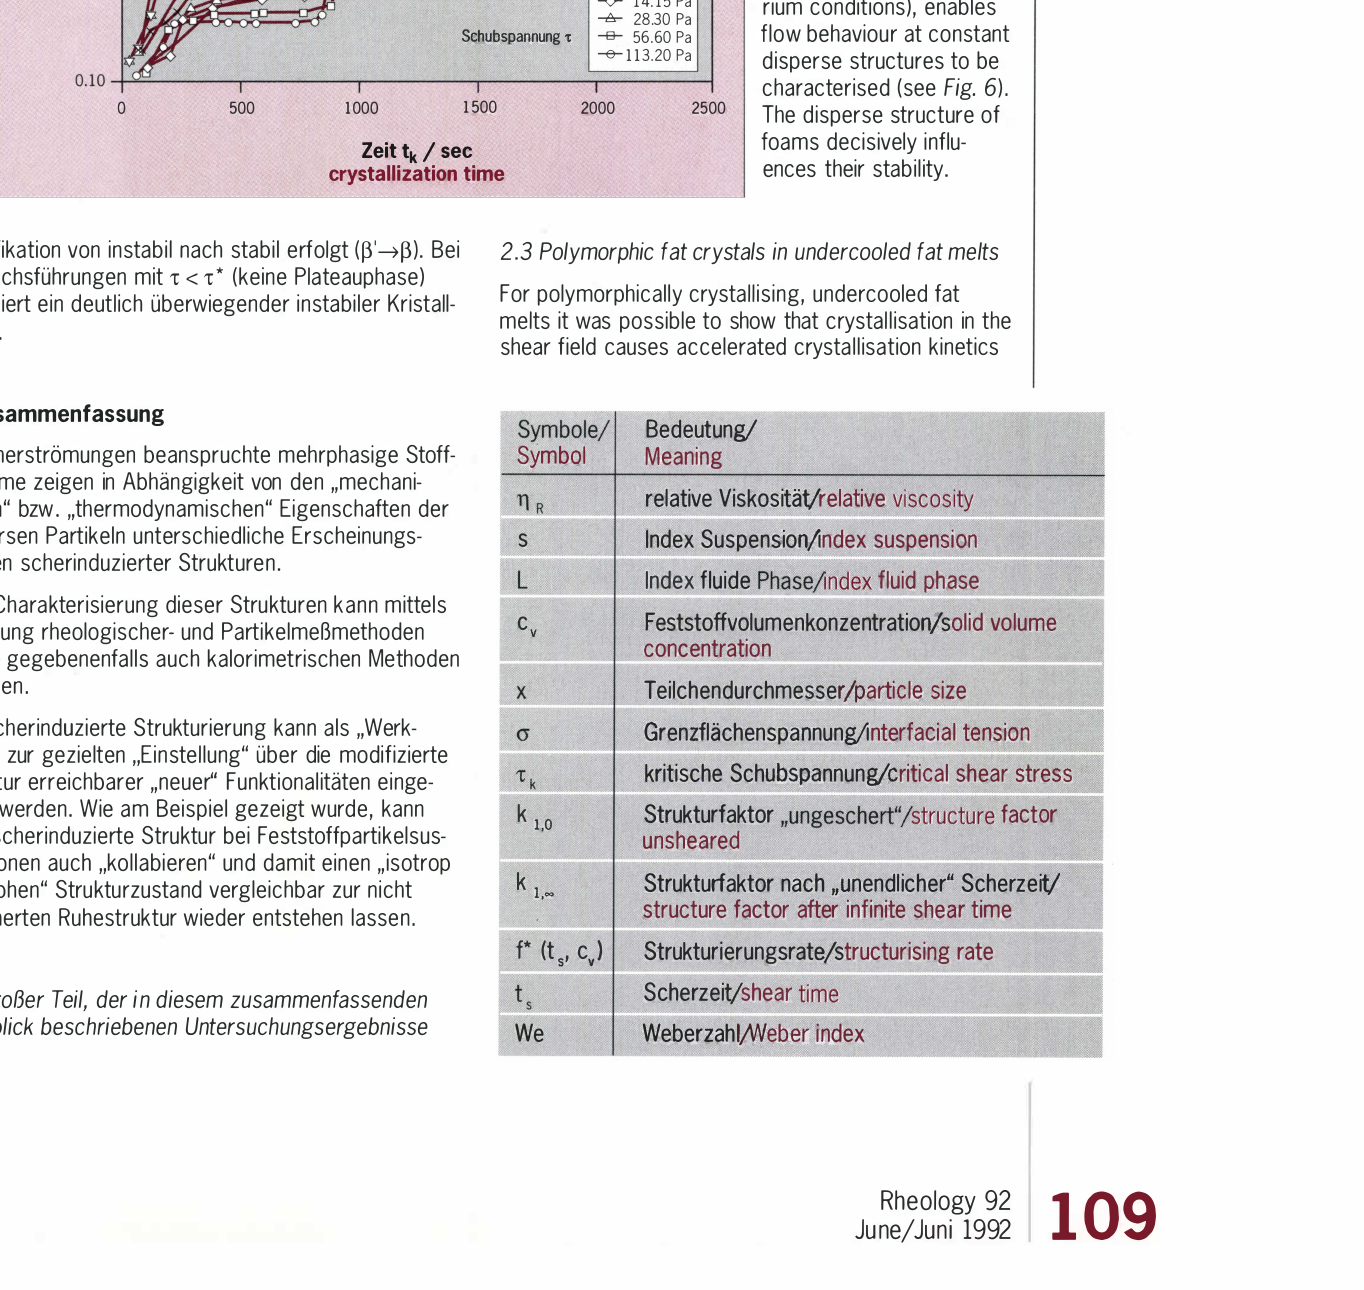
Fig. 7: Time/viscosity function for shear crystallization experiments (cone and plate gap) - cocoa butter 1'1• =20 oc 10.00 ,--......,-----------,..-------------,